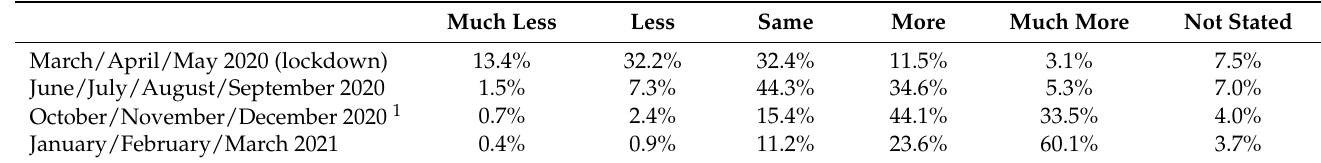
Table 2. Number of treatment requests/patient registrations compared to before the pandemic at four different time points (N = 454, percent